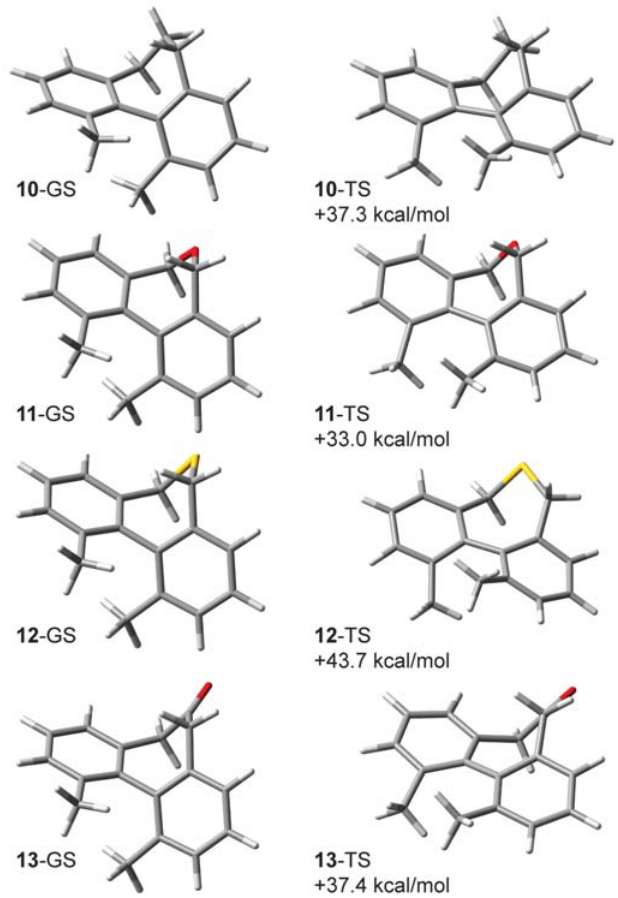
Thiepin 12 appears to be an outlier with a smaller inverse effect (0.959) caused by a reduced ZPE/  H ‡ contribution. The degree of mismatch between these terms (ZPE −  H ‡ , 10- d 11 - d : − 0.035, 12 - d : − 0.043, 13 - d : − 0.046) are greater and opposite in sign when compared with 10 10 10 2 - d (+0.023). With the partitioning behavior (Figure 2) in mind, this leads to some of the largest ZPE 10 (0.66) and EXC (1.32) terms that we have encountered for systems computed at temperatures approximating experimental racemization conditions. Figure 8. B3LYP/6-31G(d,p) lowest-energy ground state (GS) structures and transition structures (TS) and their computed enthalpies of activation (  H ‡ ) for compounds 10 – 13